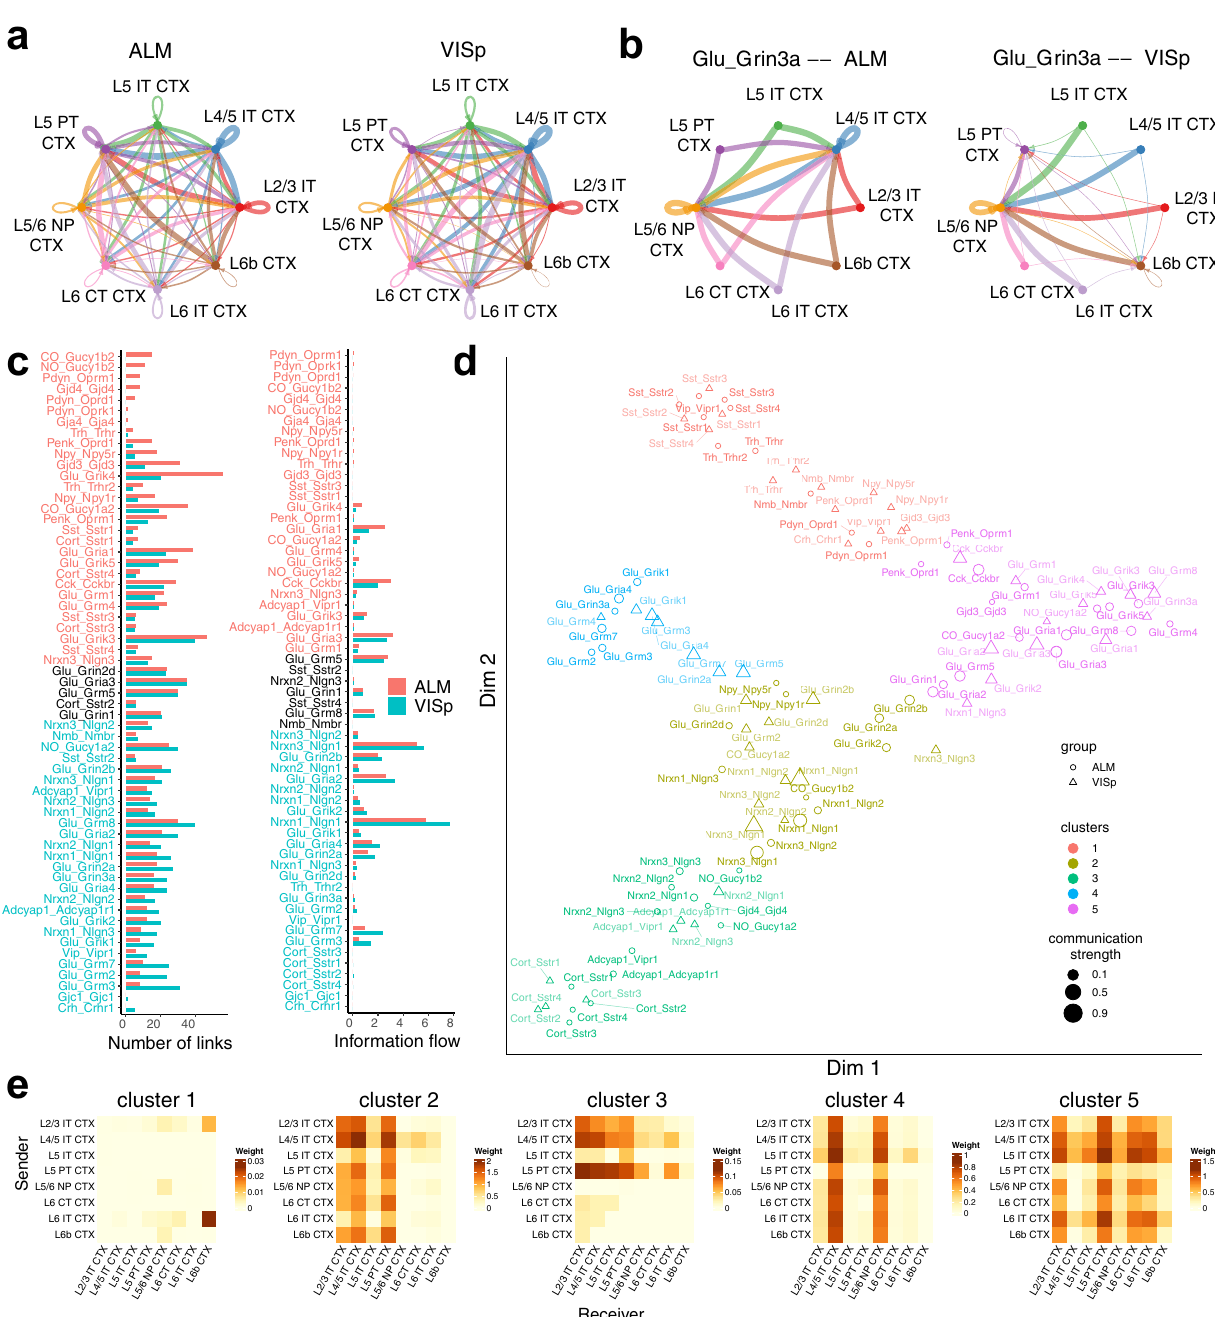
VISp for each interaction pair. d Projecting interactions for ALM and VISp onto a two-dimensionalmanifoldaccordingtotheirfunctionalsimilarity.Eachinteraction pairis representedbyacircle (forVISp)ortriangle(forALM), whose colorandsize indicatethefunctionalgroupandtotalcommunicationstrength(normalizedbythe maximum), respectively. e Heatmaps of the aggregated interlaminar excitatory communication networks for the fi ve interaction clusters in ( d